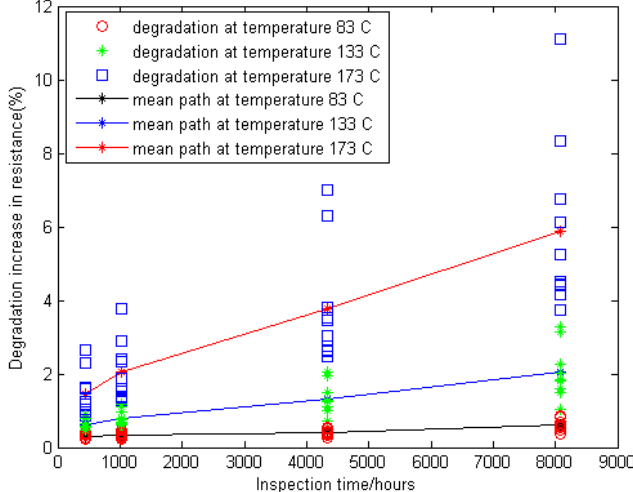
Figure 1. Sample degradation data at different temperatures.